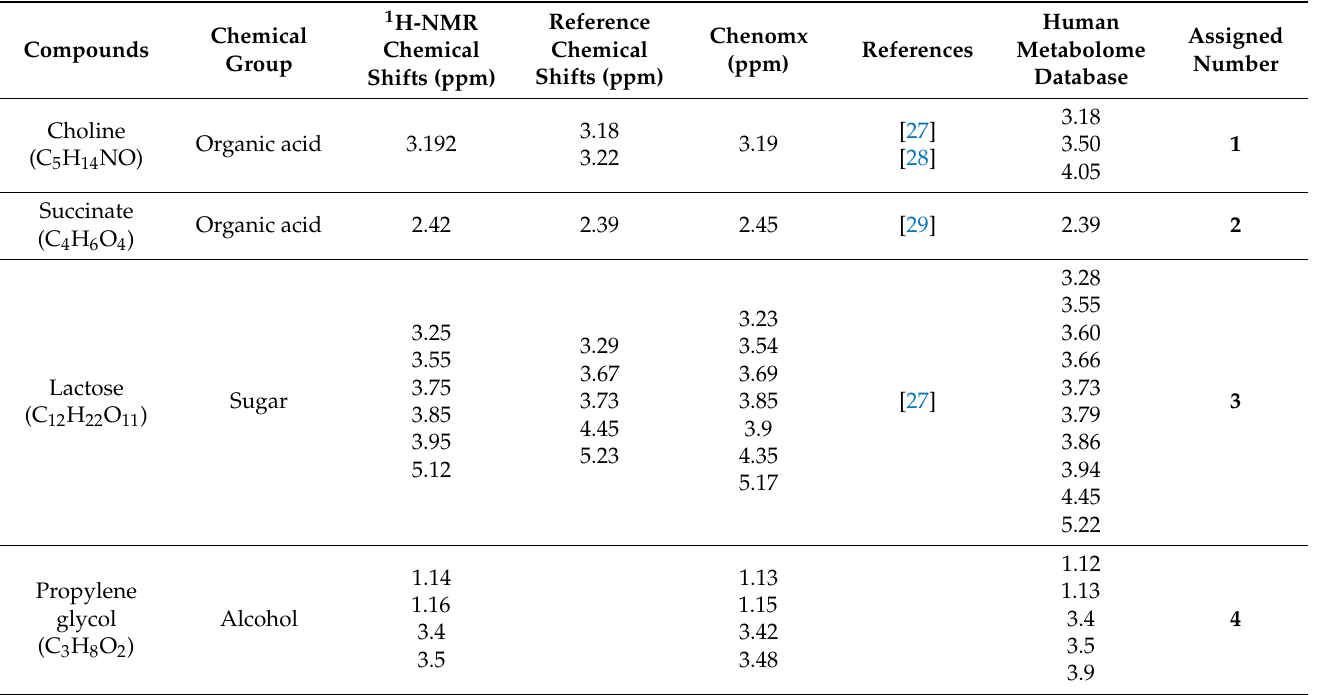
Table 1. Annotation of 1 H-NMR spectral regions and chemical shifts of the four compounds identi- fied from the Hypoxis hemerocallidea leachate.